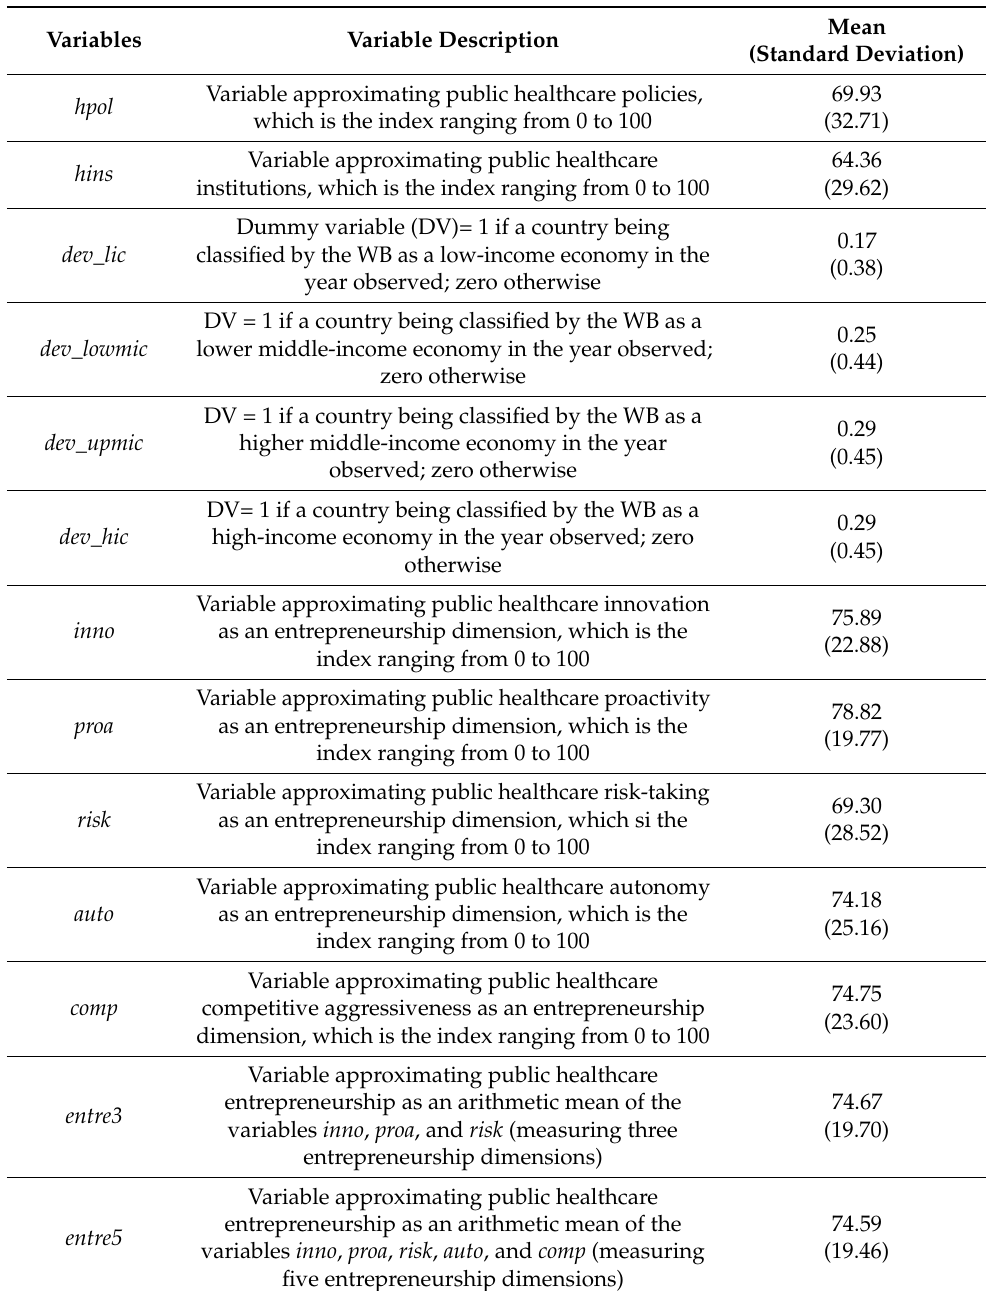
Table 1. Variable description and summary